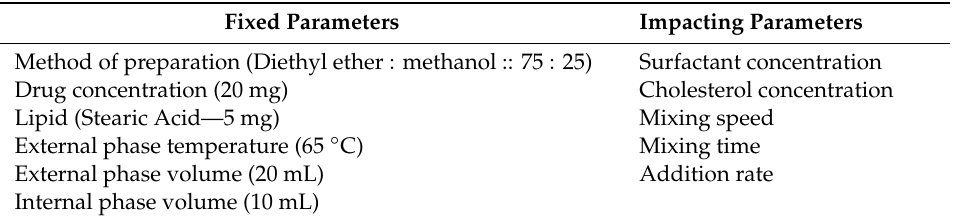
Table 4. Summary of fixed and impacting parameters for desoximetasone